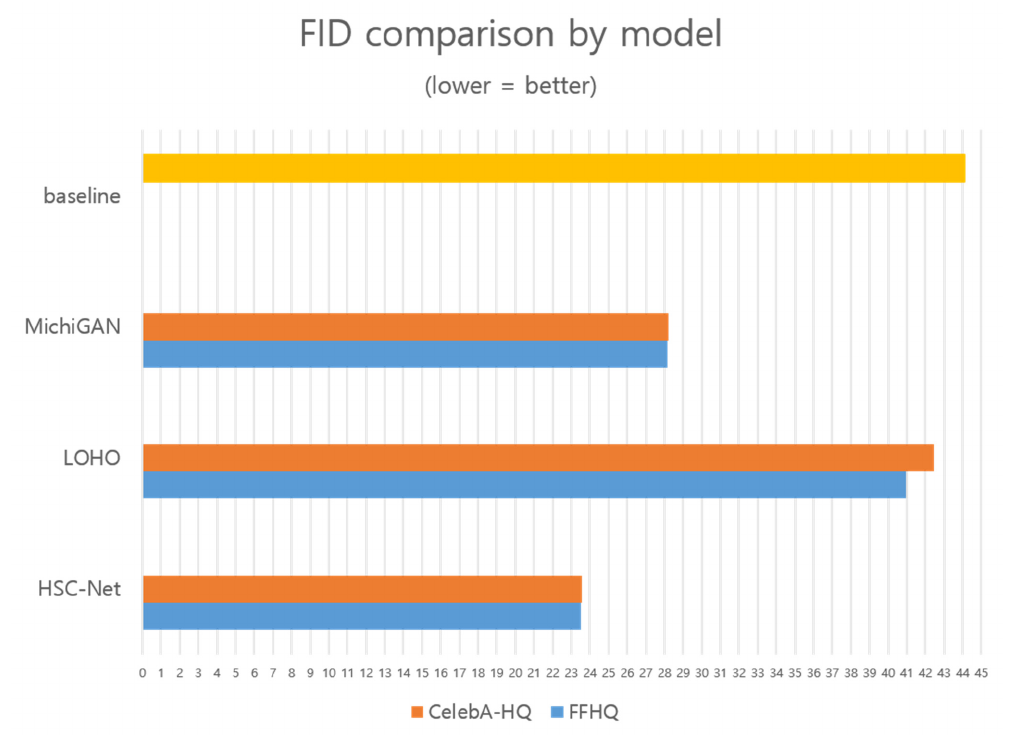
Figure 10. Comparison of FID, which is the most-used metric for evaluating GANs, by model.